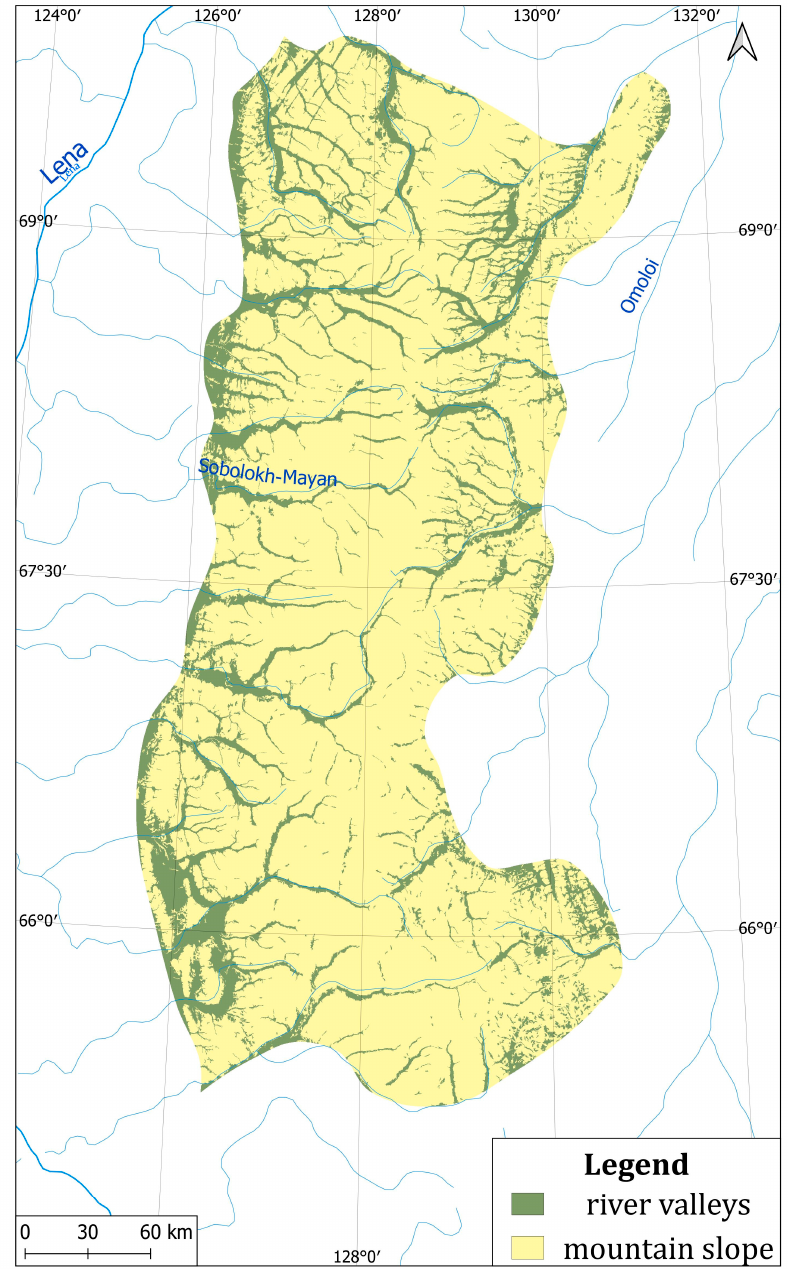
5 Figure 5. River valleys and mountain slopes classification of Orulgan